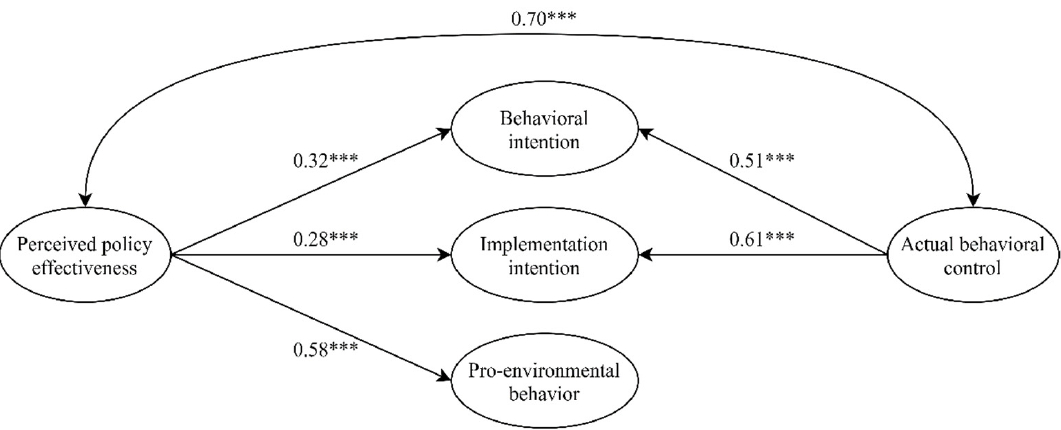
Figure 2. Direct effects of perceived policy effectiveness and actual behavioral control on behavioral intentions, implementation intention and pro-environmental behavior. * p < 0.05, ** p < 0.01, *** p < 0.001; Standardized coefficients are reported.